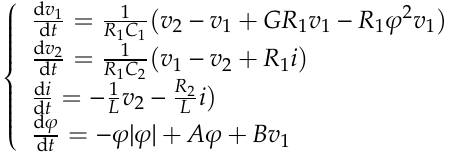
Figure 5. Memristor-based chaotic circuit.